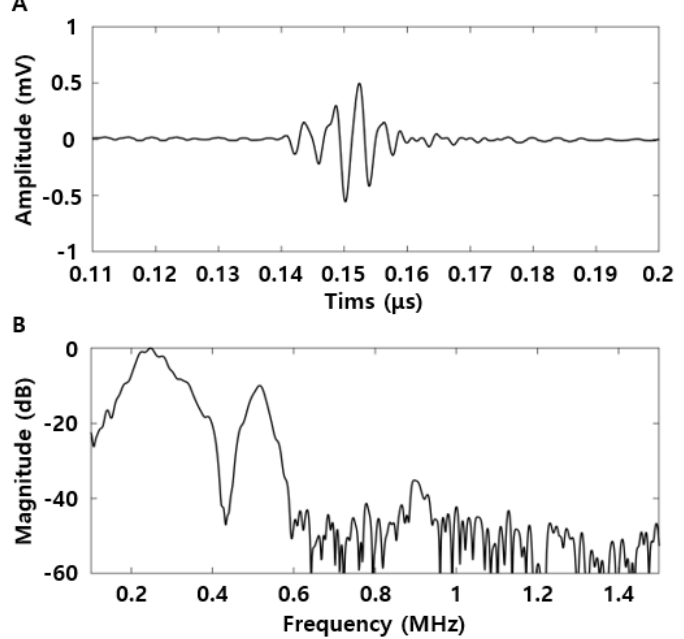
Figure 4. Pulse-echo response of focused ultrasound transducer. ( A ) Time-domain and ( B ) frequency Figure 4. Pulse - echo response of focused ultrasound transducer. ( A ) Time - domain and ( B ) fre- spectrum quency spectrum results.